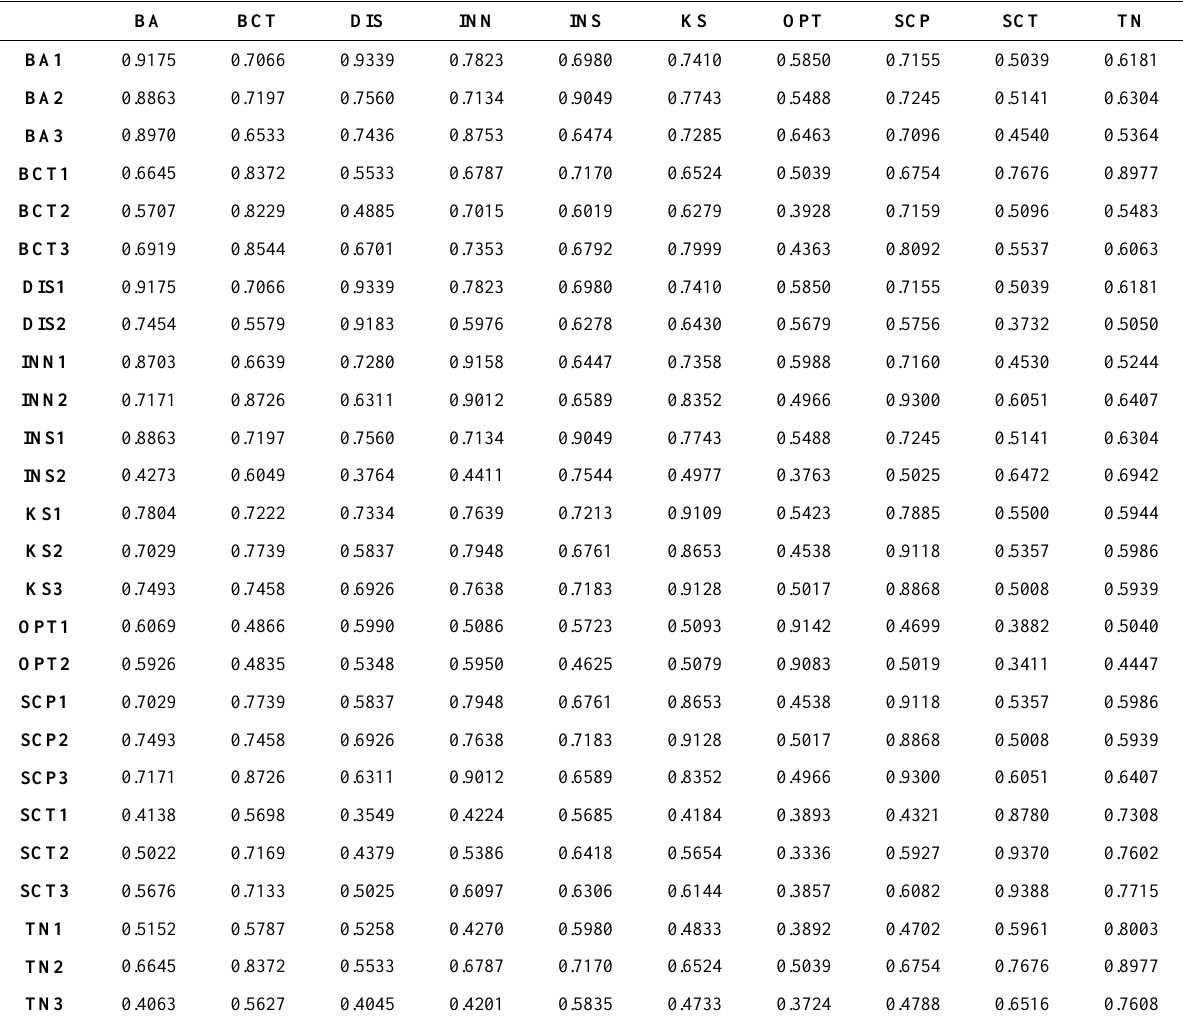
Table 5. Discriminant